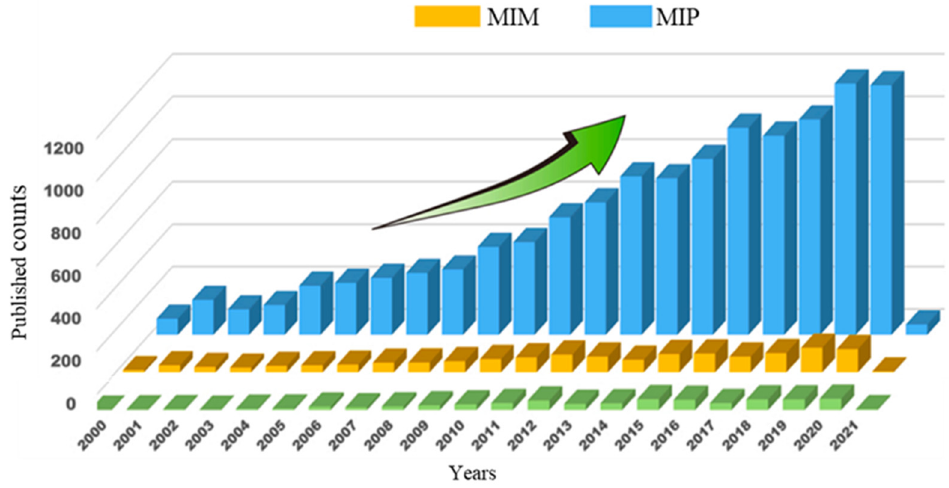
Figure 9. Published papers on MIPs and MIMs from 2000 to 2021 based on web of science core collection. (Reprinted with permission from Ref. [206]. Copyright 2021